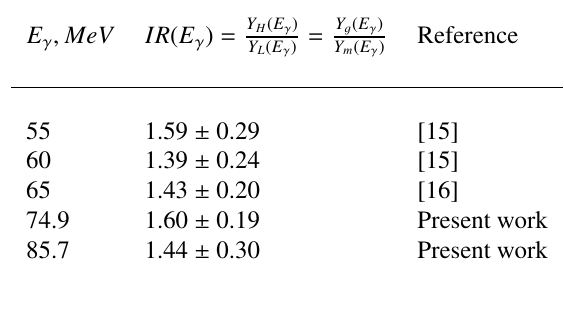
Figure 2. Fitting line for experimental points ( X , F ) of rhodium 99 m ,g Rh nuclei decay 103 Rh( γ ,4n) 99 m ,g Rh Table 1. Reactions, the bremsstrahlung energy end-points E γ max and the experimental isomer ratios IR = Y H for nucley, obtained Y L in our